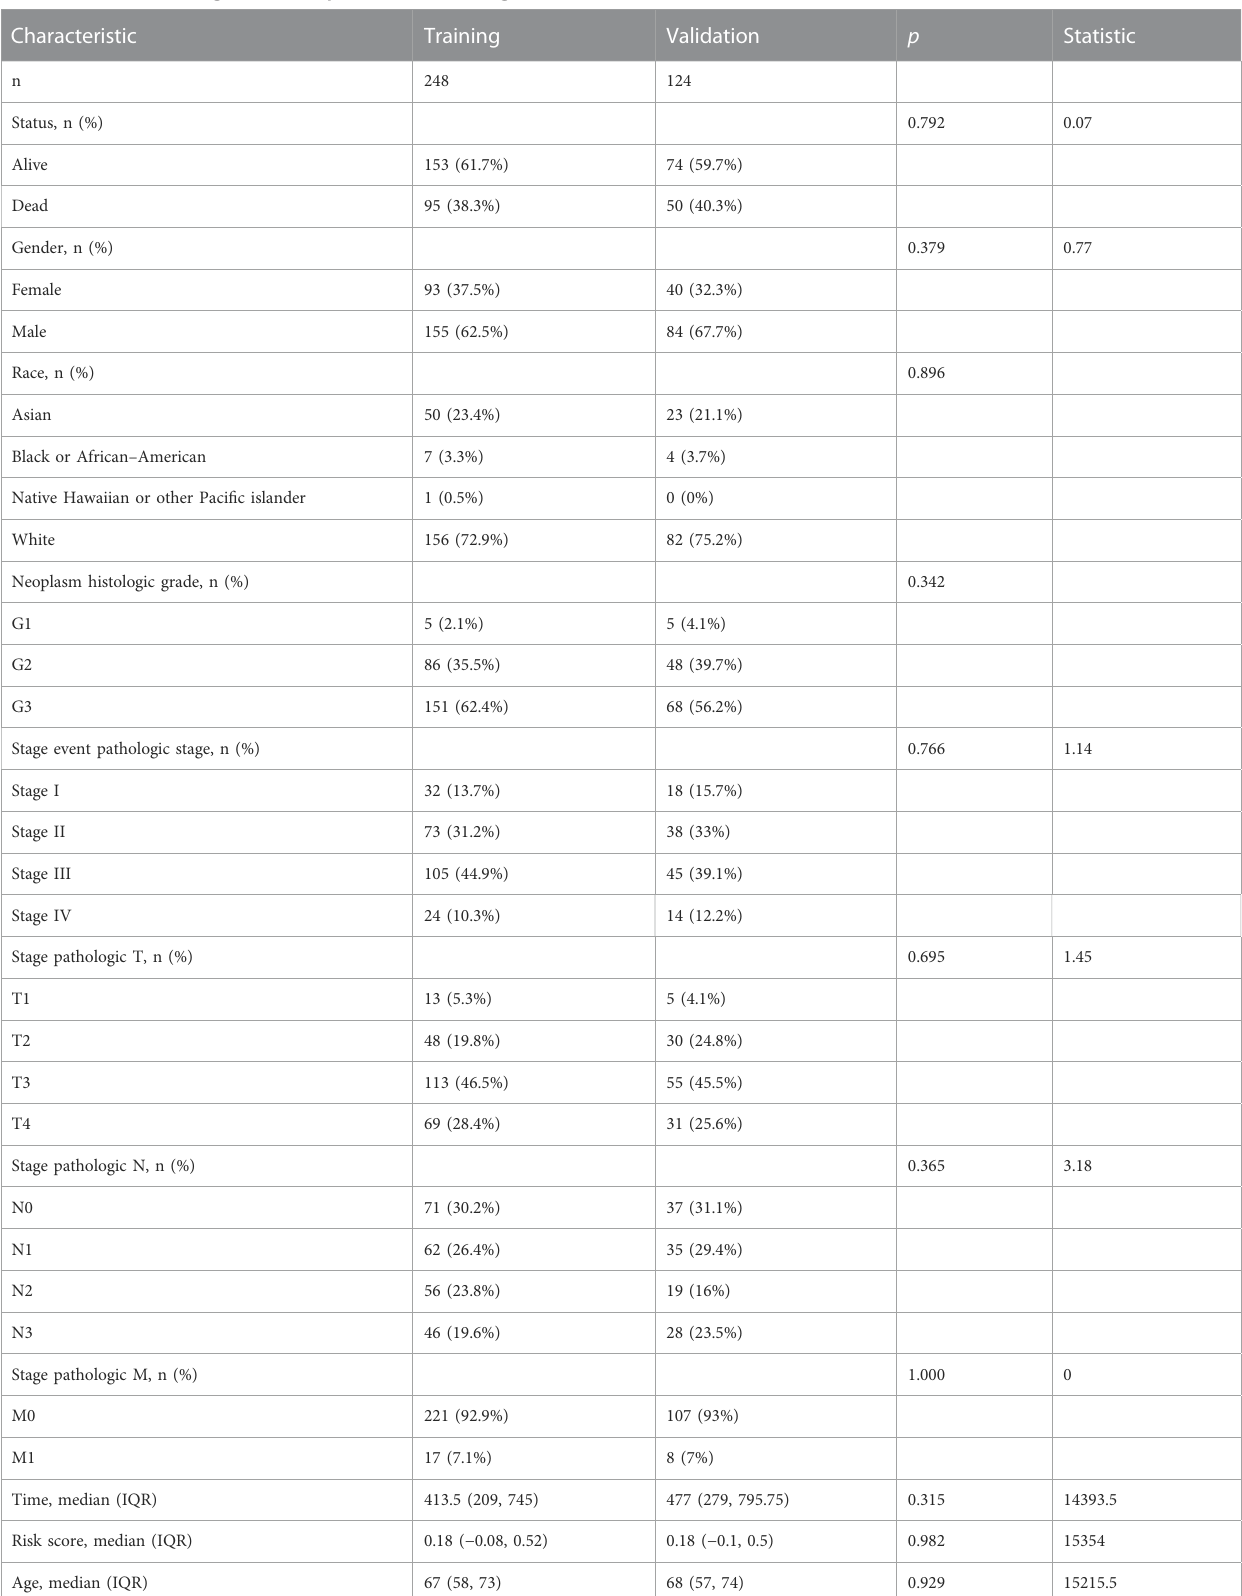
TABLE 1 Characteristics of gastric cancer patients in the training cohort and validation